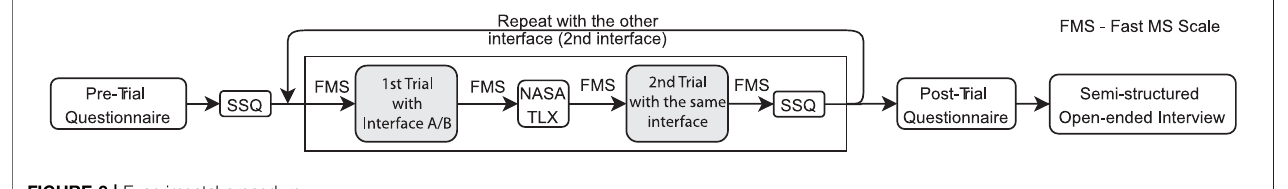
FIGURE 3 | Experimental